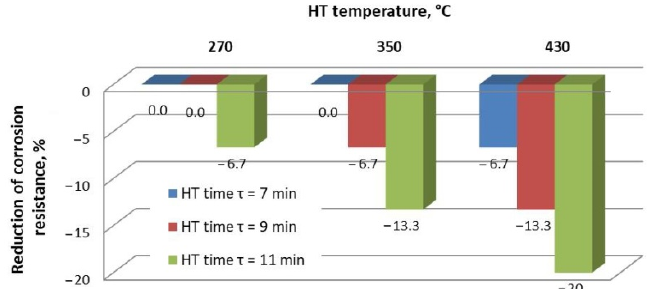
Figure 5. Changes in the corrosion resistance as a result of heat treatment expressed as a percentage reduction of the starting value.